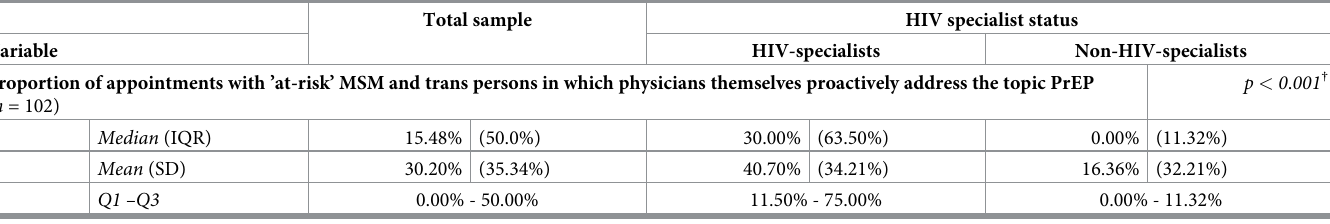
Table 3. Advice on PrEP during appointments with MSM and trans persons who met the criteria to be offered PrEP according to the German and Austrian guide- line (at-risk patients). Total sample HIV specialist